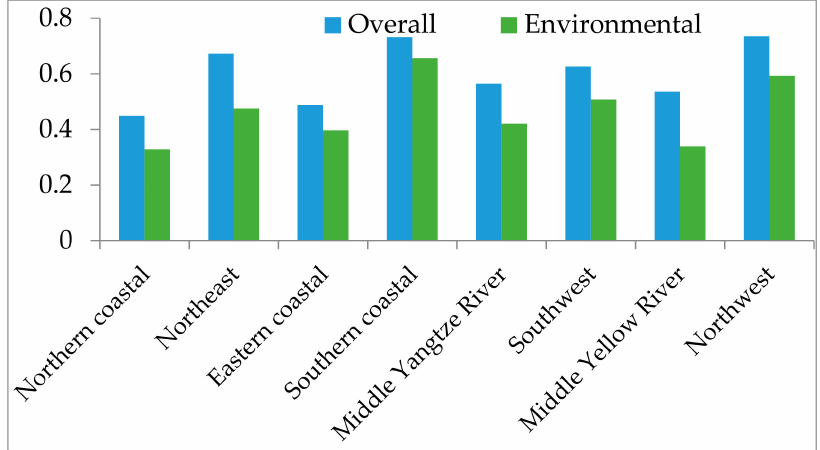
Figure 3. Mean urban PM 2.5 efficiencies for different areas in China.